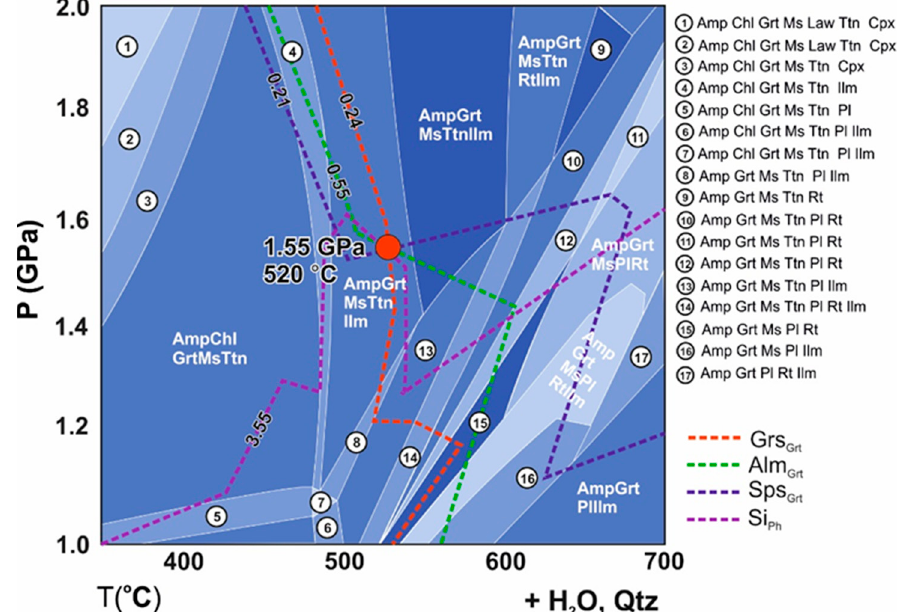
Figure 26. P–T pseudosection calculated for the D1 peak metamorphic stage of Haˇcava blueschists using a modified composition of an HAC-1 sample (Table 9) in the MnO–Na 2 O–CaO–K 2 O–FeO–MgO– Al 2 O 3 –SiO 2 –H 2 O–TiO 2 –O 2 (MnNCKFMASHTO) system by Perple_X thermodynamic software [30,102] with Grt endmember and Si-in-Ph content